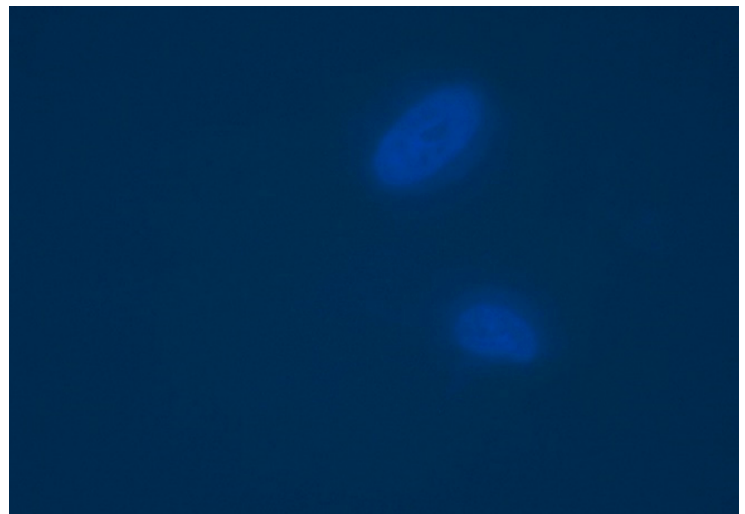
Figure 9. NOF 316 showing nuclear DAPI staining with the IgG antibody. (magnification ×100, Fluorescence at 1.3 s, DAPI at 0.07 s).